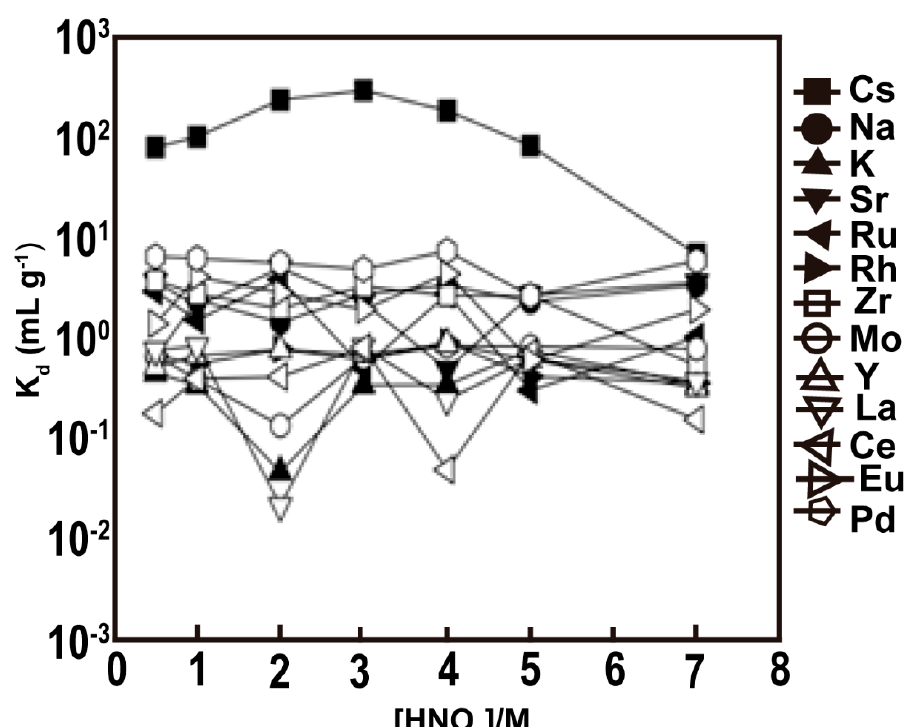
Figure 9. Dependence of Kd of tested metals on (Calix {4} + dodecanol)/SiO 2 -P. [metal] = 10 ppm; temperature = 298K; and phase ratio = 0.05 g /10 cm 3 [56].